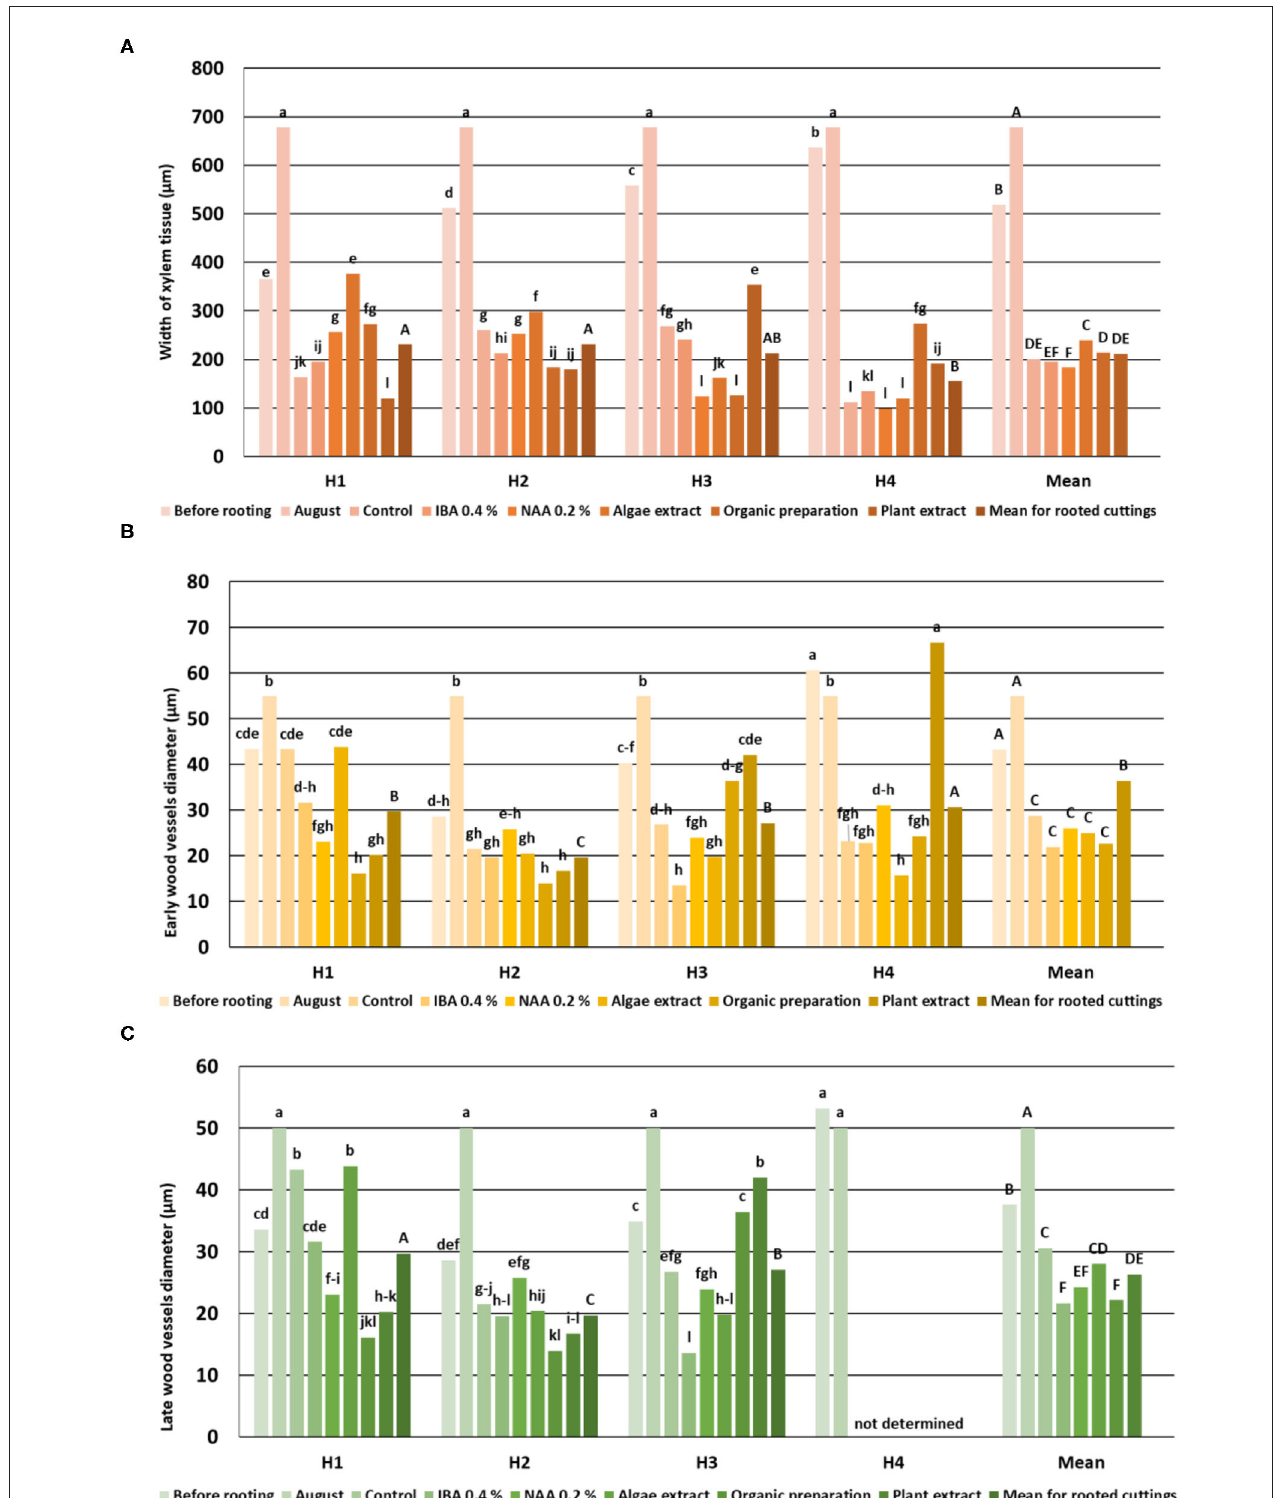
FIGURE 4 | Width of Rosa “Hurdal” xylem tissue (A) , early- (B) , and late-wood (C) vessels in stems before rooting, cuttings after 24 days of the rhizogenesis process and in stems of stock plants cut in the first days of August. Control—the control cuttings; IBA 0.4%—Ukorzeniacz A aqua (0.4% IBA); NAA, 0.2%—Ukorzeniacz B aqua (0.2% NAA); Algae extract—watering with 0.6% Bio Rhizotonic (10ml) after planting and 10 and 20 days later; Organic preparation—watering with 0.4% Root Juice TM